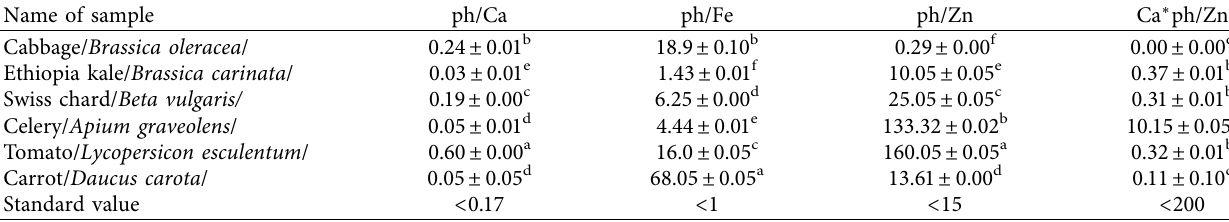
Table 4: Molar ratios of commonly consumed vegetables.